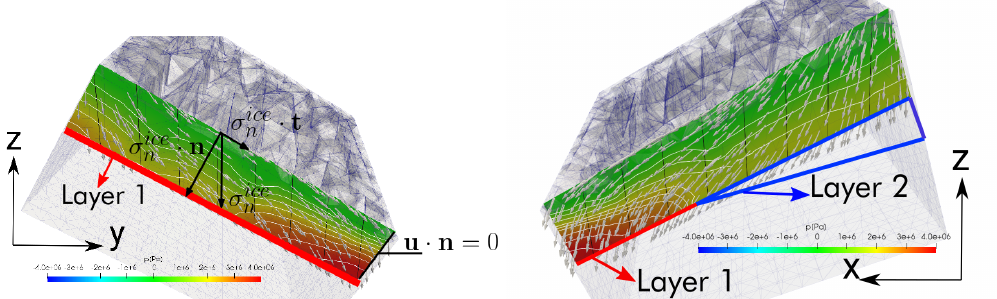
Figure 13. Front (on the left) and lateral (on the right) view of the basin. The color marks the pressure field, the arrows shows the direction of the solid displacement (in the interior and on the boundary of n = 0) and the black lines show the direction of gravity. The configuration of the the domain, that is u · basin layers is also shown, to facilitate the interpretation of the